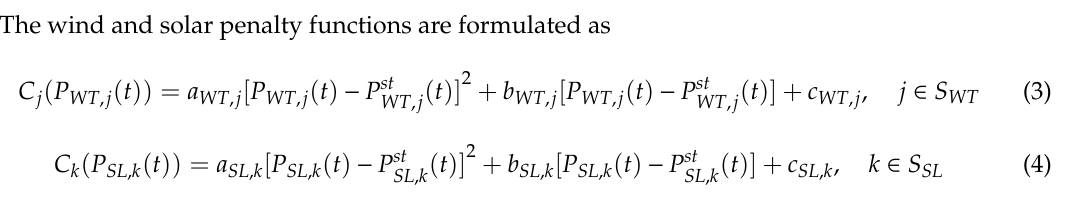
Figure 1. The structure of the considered AC/DC hybrid microgrid.